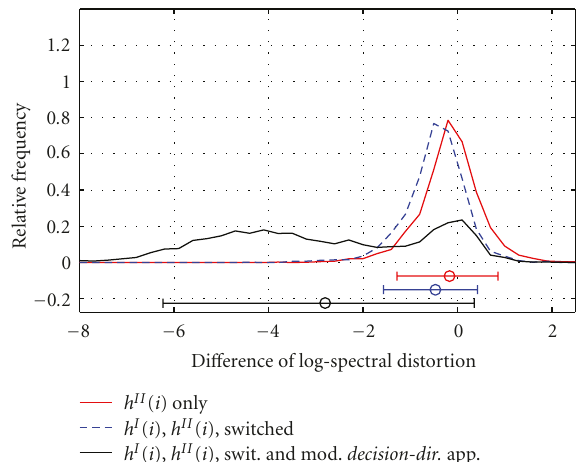
Figure 21: Relative frequencies of the improvements of log-spectral distortion in 2792 occurrences of the phoneme [d]. Values less than zero signify less distortion of the proposed system as compared to a system using a square-root Hann window for spectral analysis- synthesis that produces the same small system delay.